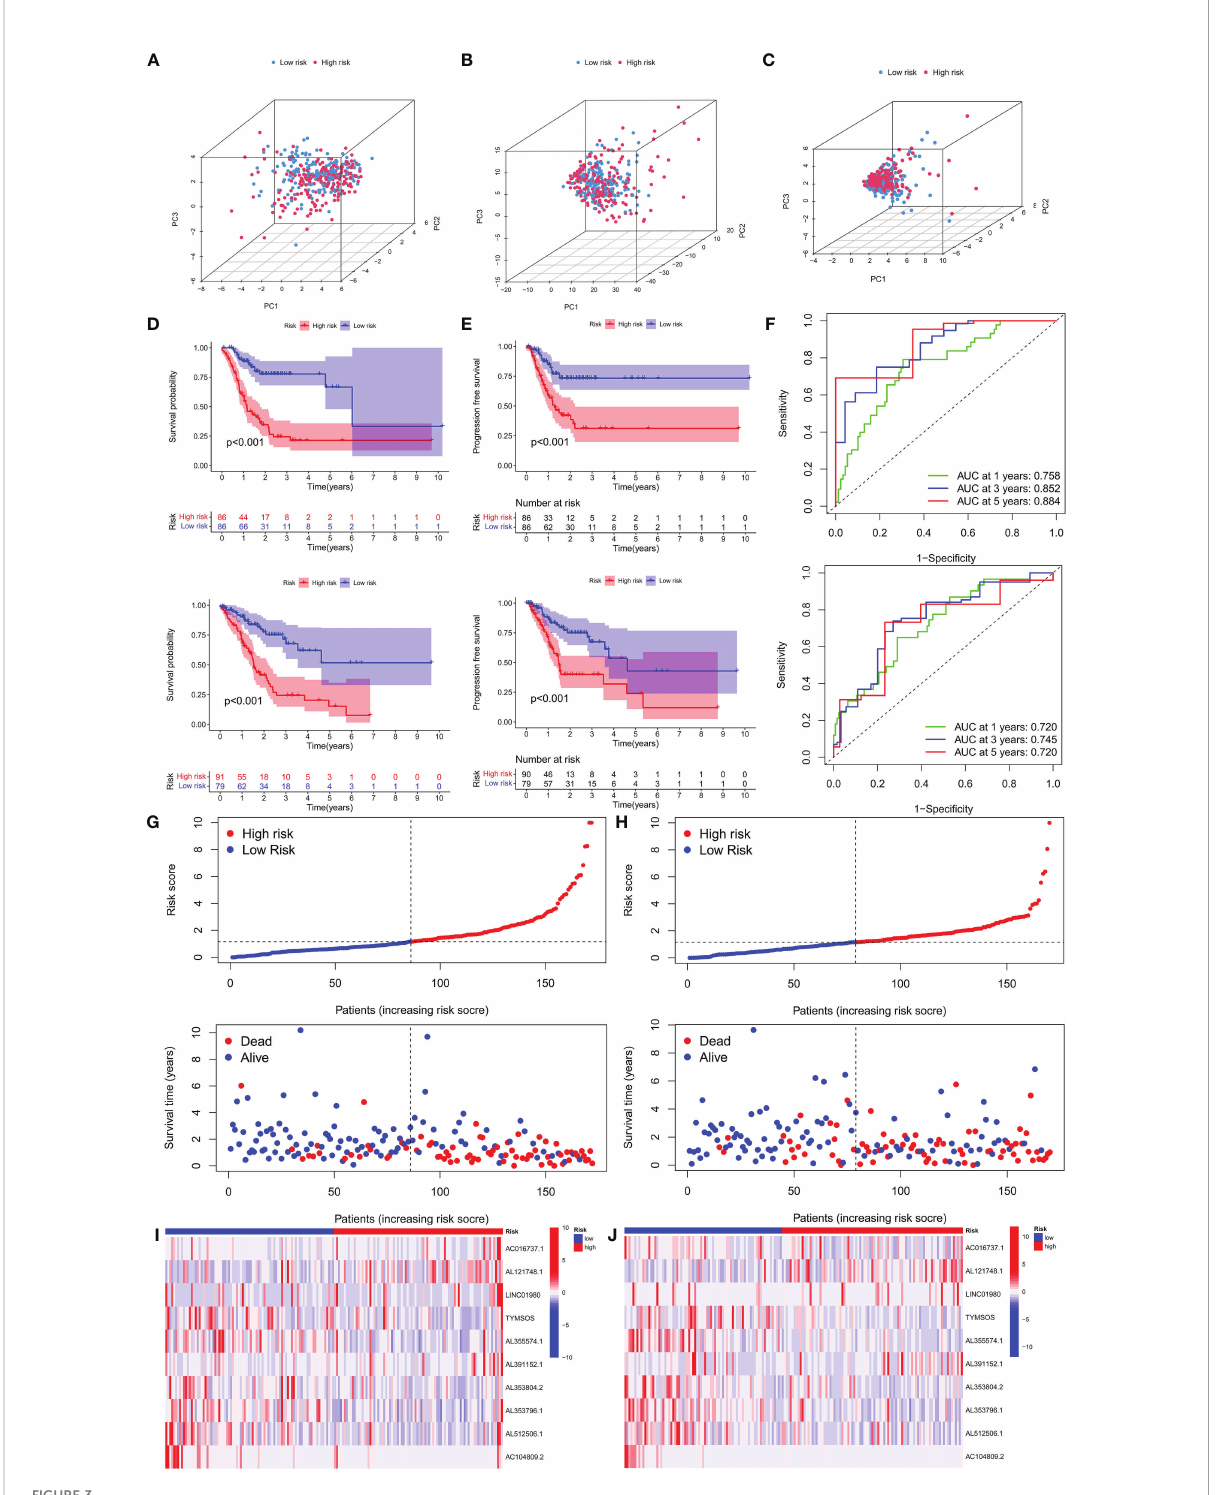
FIGURE 3 Survival analysis and validation of the risk model in the training set and testing set. (A) PCA analysis was conducted for the entire gene set, (B) 19 CRGs, and (C) 10 CRLs in the risk model. (D, E) The survival difference of patients with different risk patterns in the training set and testing set. (F) A time-dependent ROC curve was plotted to test the accuracy of the risk model. (G, H) Patients in the training set and testing set were ranked according to the risk score. Then, the survival status difference of the patients between the two groups was visualized. (I, J) Heatmap showed the RNA level of the 10 CRLs in the training set and testing